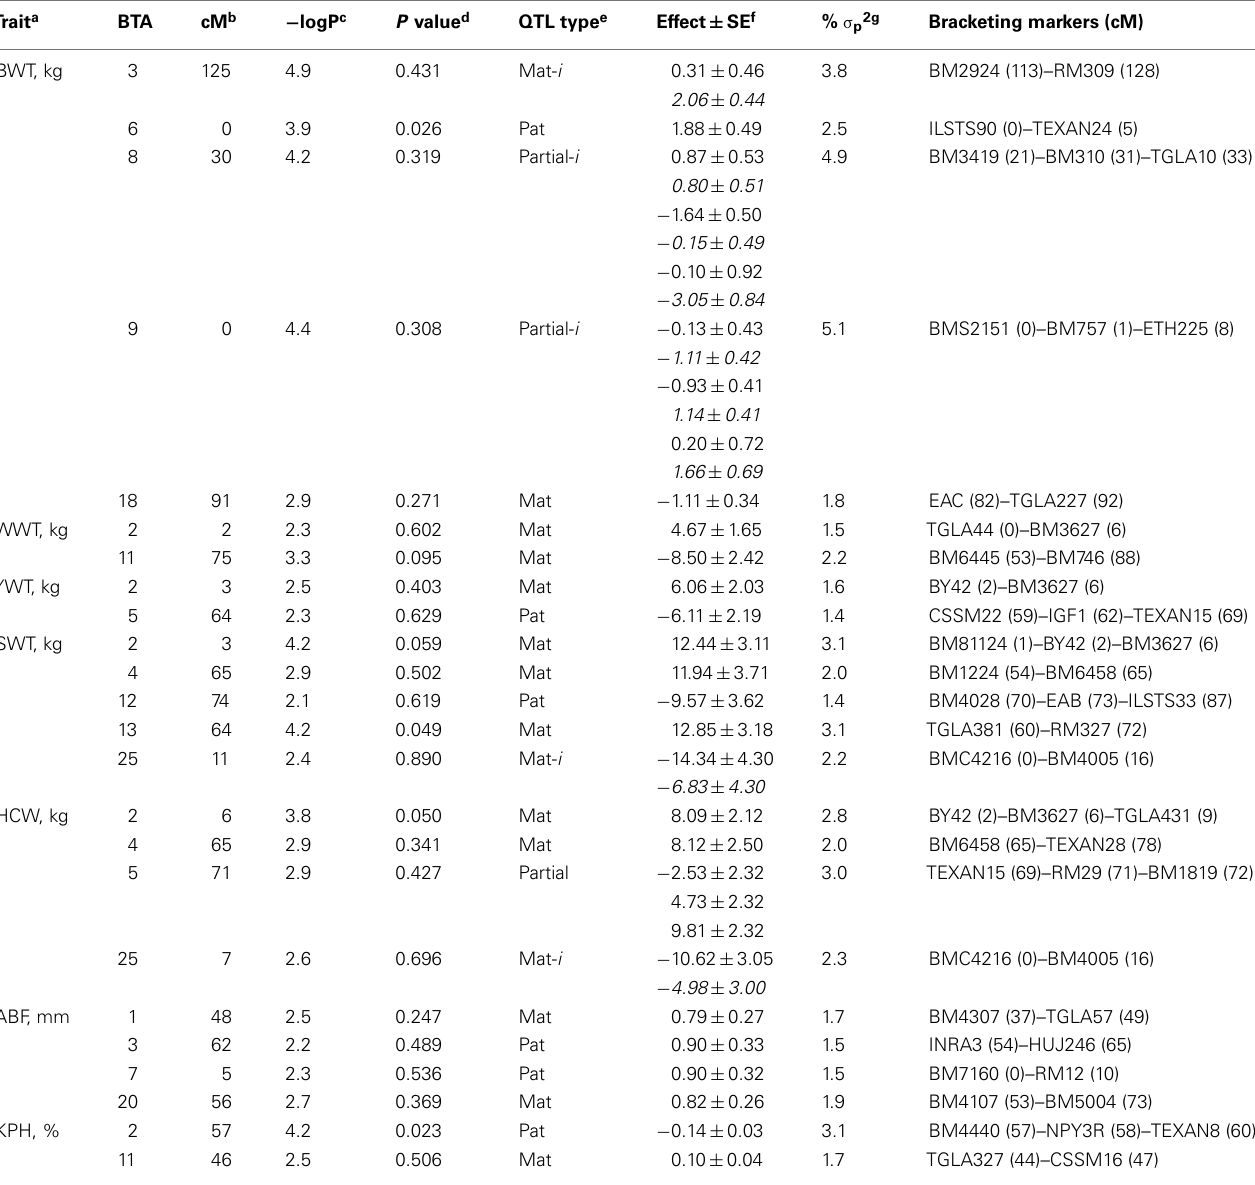
Table 1 | Most likely position, test statistic values and estimated effects of parent-of-origin QTL for growth and beef carcass traits that were detected with at least 5% chromosome-wise evidence for